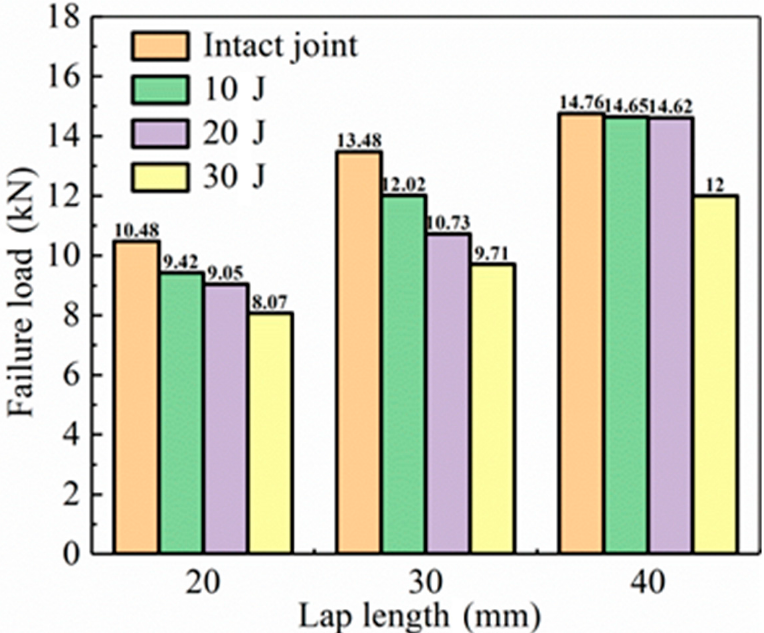
Figure 19. The residual strengths of SLJs with different overlap lengths and impact energies.